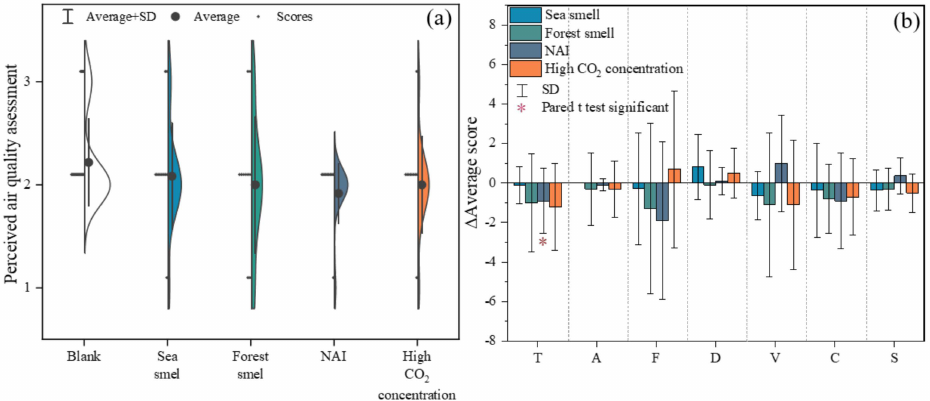
Figure 12. ( a ) The score of perceived air quality in the four scenario and blank test and ( b ) the Profile of Mood States (POMS) scores in the four scenario and blank